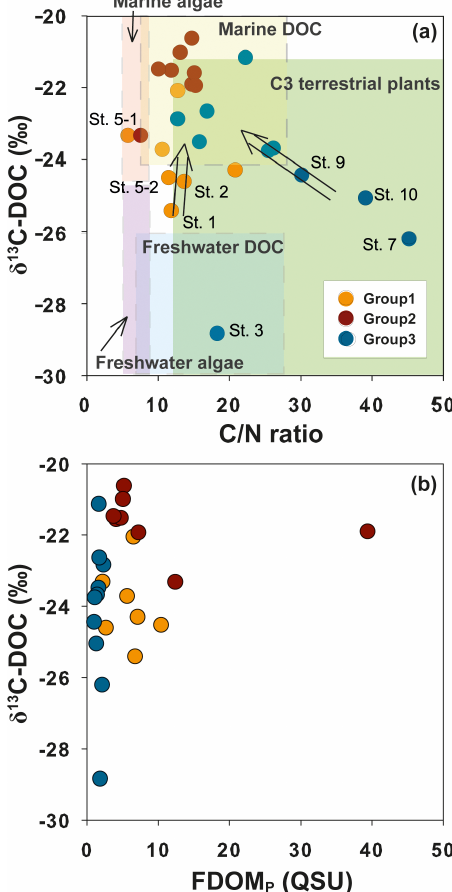
Figure 5. Relationships between δ 13 C-DOC values and (a) the DOC / DON (C / N) ratio and (b) FDOM P in Masan Bay, Repub- lic of Korea. The ranges of the DOC / DON ratio and δ 13 C-DOC values for each group are based on the values reported by Lamb et al. (2006) and Beaupré